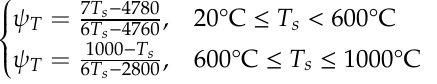
Figure 15. Integral points of the steel tubular members.